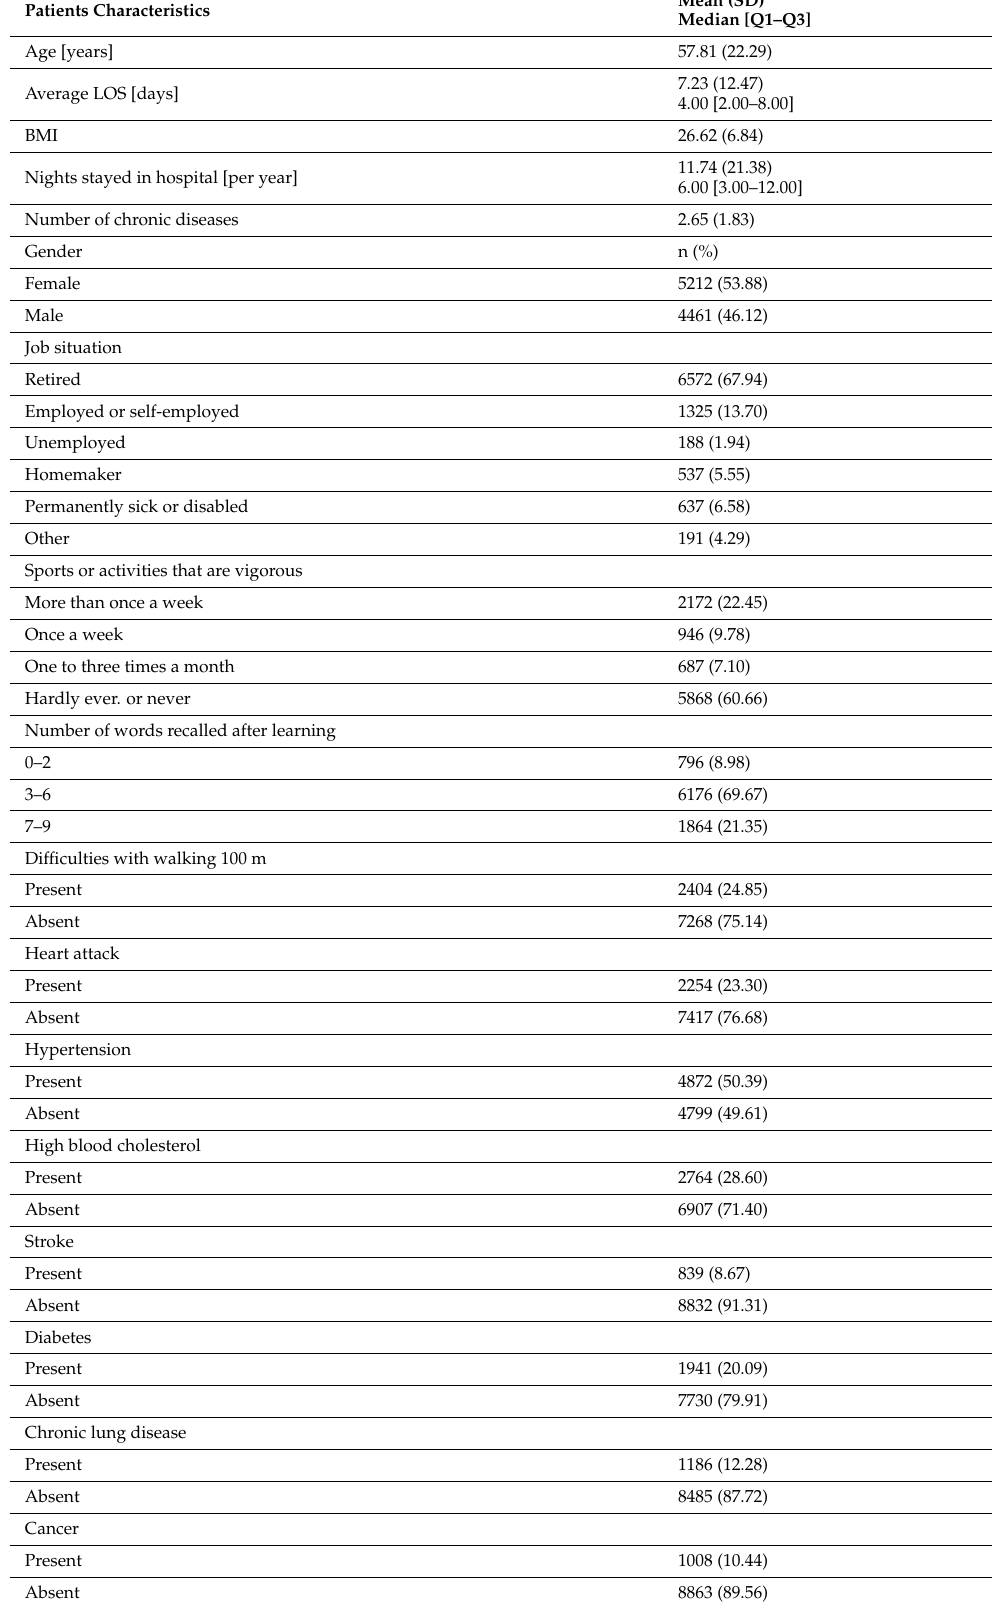
Table 1. Demographic and health characteristics of the population studied (n = 9671). Patients